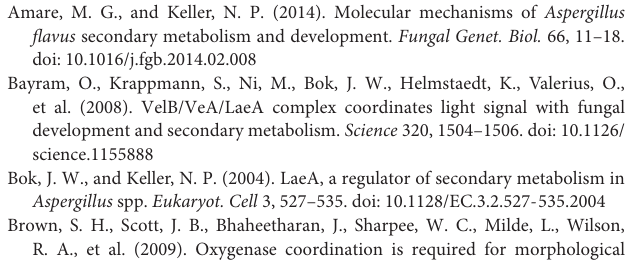
FIGURE S1 | History of Aspergillus flavus double mutant TXZ21.3. A. flavus NRRL3357.5 ( pyrG − ) from He et al. (2007). KU70 (AFLA_061470) ORF was replaced by A. parasiticus pyrG to get TJW149.27, then the ku70 gene locus pyrG was knockout to get TJES19.1. A. fumigatus pyrG was used to replace the argB ORF in TJES19.1 to get TJES20.1, and then the fumigatus pyrG in the argB locus was deleted again to get the TXZ21.3. FIGURE S2 | Southern blot analysis of the mutants in this research. (A) Southern blot of the deletion and overexpression strains. (B) Southern blot of the auxotroph mutants complement to prototroph. FIGURE S3 | DAPI stain of the (cid:49) nosA and (cid:49) ham mutants. Fresh spores were harvested from the strains with 0.05% Triton X-100 and centrifuged at 3000 rpm for 5 min. The supernatant was removed and conidia were washed twice with 1X Phosphate Buffered Saline (PBS). The pellet was re-suspended with 200 µ l DAPI stain solution. DAPI stain solution was prepared by adding 5 µ l of 10-mg/ml stocks of DAPI (40, 60-diamino-2-phenylinodole, Sigma–Aldrich, United States) plus 100- µ l antifade PPD (P-phenylenediamine, Sigma–Aldrich, United States, stock solution 1 ng/lL) plus 900 µ l of 70% glycerol. Conidia were incubated in the solution at room temperature in the dark for 20–30 min. Stained conidia were washed twice with 1X PBS buffer and then twice with water. The conidia were observed under a fluorescence microscope (Zeiss AxioMagerA10) using a DAPI filter set. (A) (cid:49) nosA (TXZ20.1). (B) (cid:49) hamE (TXZ5.2). (C) (cid:49) hamF (TXZ6.2). (D) (cid:49) hamG (TXZ7.2). (E) (cid:49) hamH (TXZ8.1). (F) (cid:49) hamI (TXZ9.16). FIGURE S4 | NosA positively regulates hamE-I in GMM medium. 10 7 spores were inoculated into 50 ml GMM liquid medium for 48 h at 220 rpm at 29 ◦ C. RNA was extracted for Northern blot analysis using the probes described in section “Materials and Methods.” FIGURE S5 | Sporulation of (cid:49) hamE-I and (cid:49) nosA mutants in GMMUU medium. 10 ml top agar GMMUU medium [0.5% (w/v) agar] containing 10 6 spores were overlaid on 20 ml GMMUU agar plates, then plates were inoculated at 29 ◦ C. The spores were counted from cores taken on 3 and 5 days